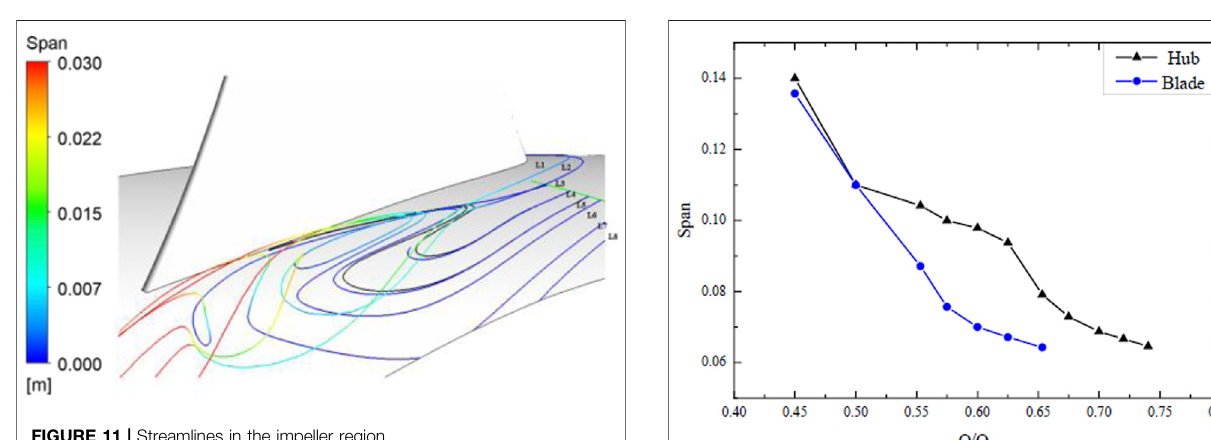
FIGURE 11 | Streamlines in the impeller region.